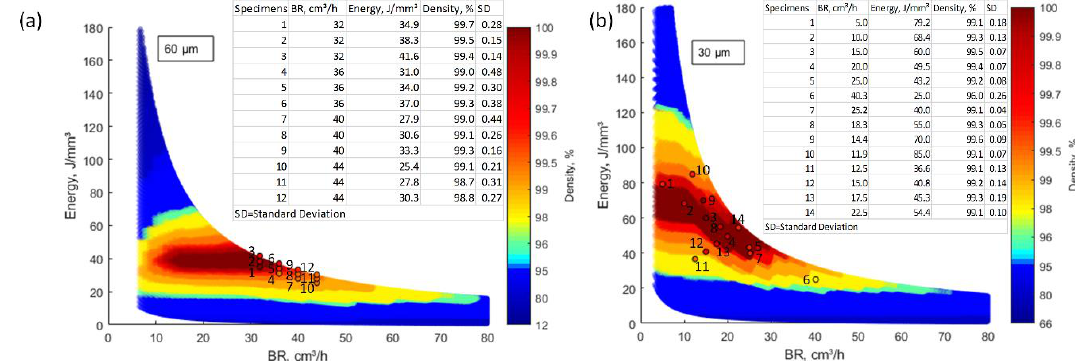
Table 4. Physical properties of Ti64 powders used for melt pool modeling [26,34].